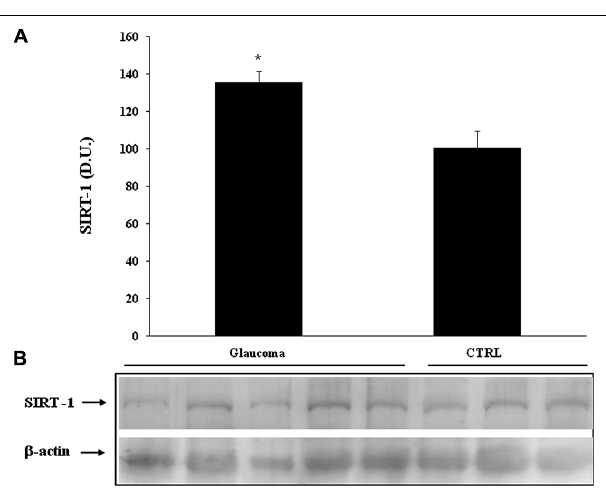
FIGURE 2 | (A) HSP-70 protein levels in lymphocytes of glaucoma and control subjects. Samples from controls and glaucoma patients were assayed for HSP-70 expression byWestern blot. A representative immunoblot is shown. β -actin has been used as loading control. (B) Densitometric evaluation: the bar graph shows the values are expressed as mean standard error of mean of 3 independent analyses. * P < 0.05 vs. control. D.U., densitometric units; CTRL, control.